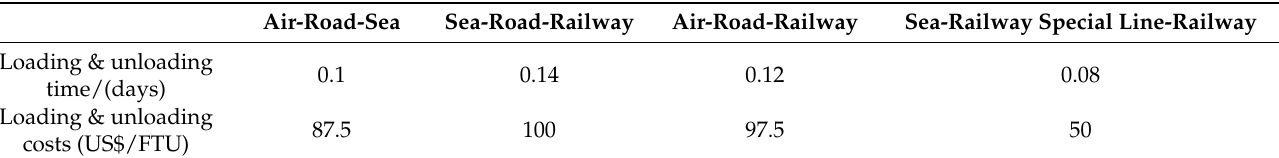
Table 2. Loading & unloading time and cost between different transportation